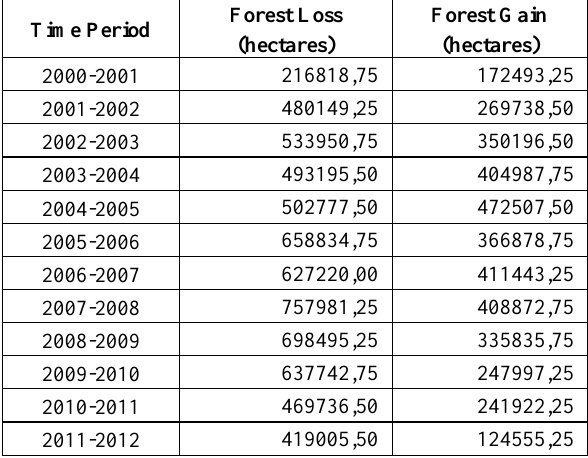
Table 1: Sample Forest Change Summary for